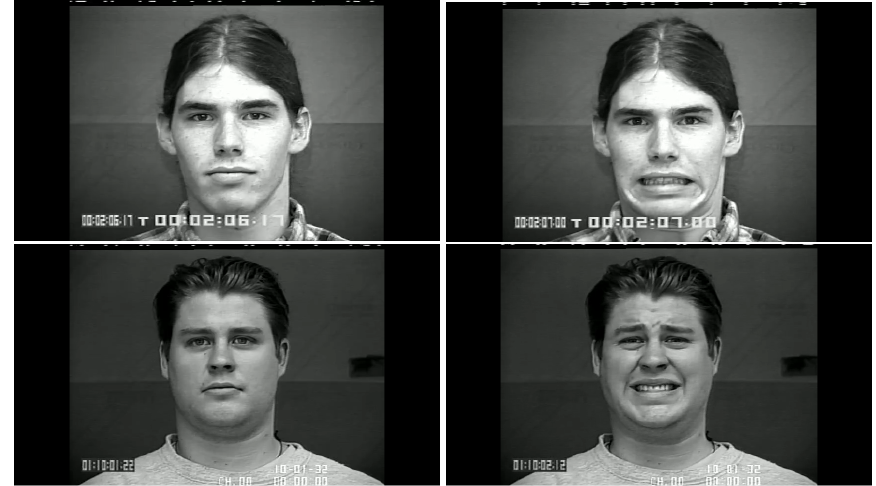
Figure 5. Two examples of fear execution in the CK+ dataset. Computational scores pointed out the expression performed by the Subject 54 ( first row ) is quantitatively worst than the one performed by the Subject 132 ( second row ).